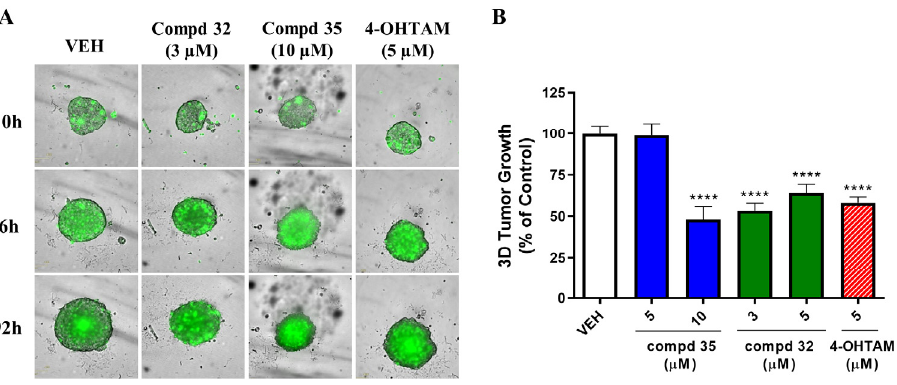
Figure 7. 5-Hydroxy-2 H -pyrrol-2-ones 32 and 35 prevent ER+ breast cancer cell spheroids growth. T47D tumor spheroids were treated with vehicle (VEH, 0.05% DMSO) or different doses of compounds (1–10 µ M) for 8 days. ( A ) Representative brightfield microphotographs of YOYO-1-labeled tumor spheroids in the absence (VEH) or presence of compounds (compd 32 , 3 µ M; compd 35 , 10 µ M; and 4-OHTAM, 5 µ M) at 0h, 96h and 192 h. ( B ) 3D-tumor growth quantification as mean ± SEM of the